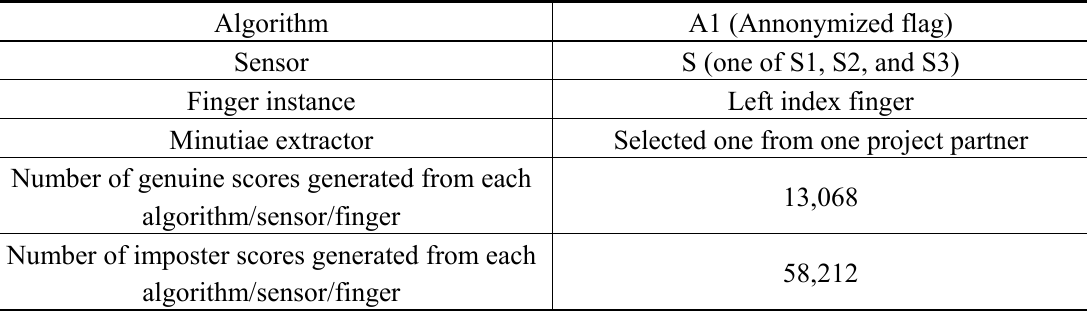
Table 1. Common settings for all fusion scenarios.